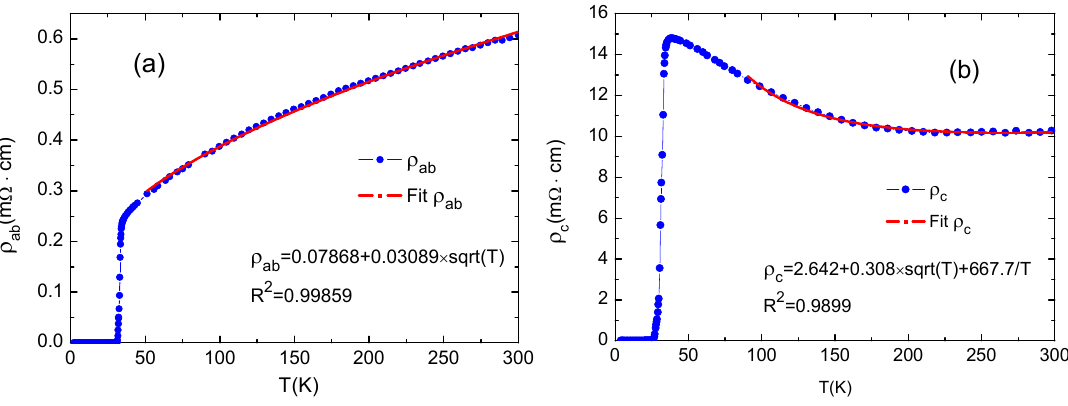
Figure 3. ( a ) The temperature dependence of the in-plane resistivity ρ ab and ( b ) out-of-plane resistivity ρ c . Due to the layered crystal structure of Ca 10 (Pt 4 As 8 )((Fe 0.86 Pt 0.14 ) 2 As 2 ) 5 , the in-plane